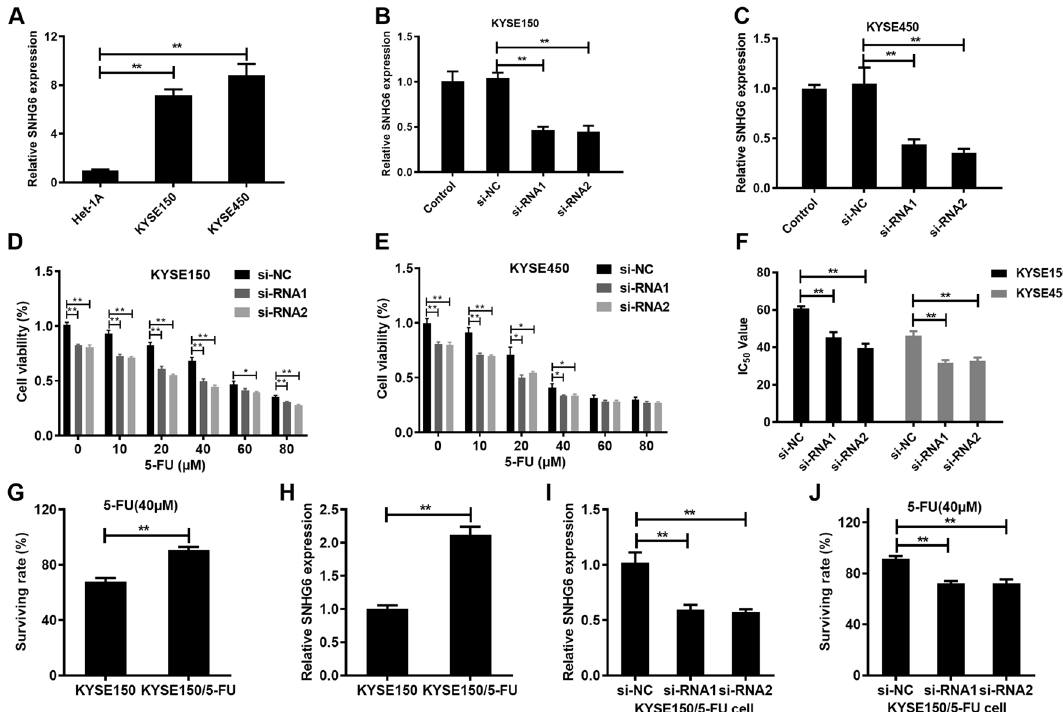
Figure 1. LncRNA SNHG6 inhibits EC cells sensitivity to 5-FU. ( A ) SNHG6 levels in EC cells and Het-1A cells. ( B , C ) Transfection of si-RNAs reduces SNHG6 expression in EC cells. ( D , E ) Transfection of si-RNAs reduces EC cells viability at varying concentrations of 5-FU. ( F ) Transfection of si-RNAs reduces the IC 50 of 5-FU to EC cells. ( G ) Surviving rate of KYSE150 cell and KYSE150/5-FU cell. ( H ) SNHG6 levels in KYSE150 cell and KYSE150/5-FU cell. ( I ) Transfection of si-RNAs reduces SNHG6 expression in KYSE150/5-FU cell. ( J ) Transfection of si-RNAs reduces the surviving rate of KYSE150/5-FU cell. *P < 0.05; **P < 0.01 (Two-way Student’s